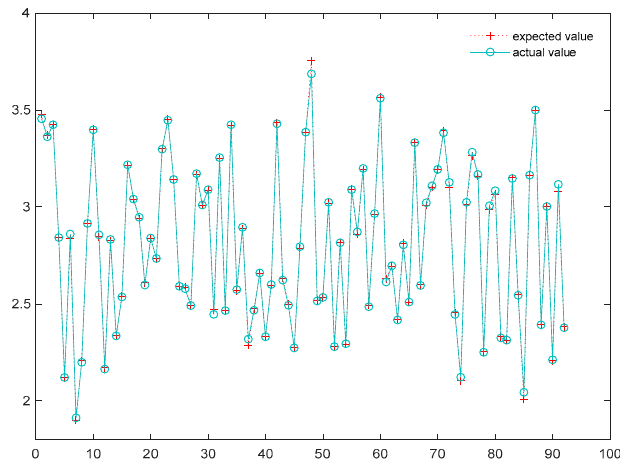
Figure A2. Relative error variation of Hongxia community.